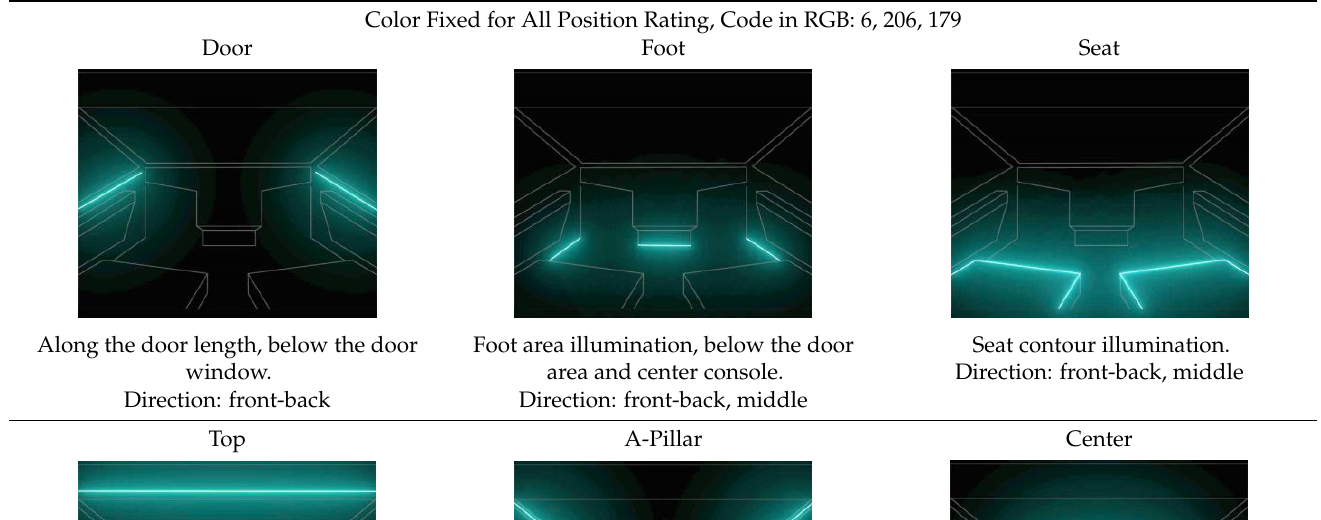
Table 2. Position settings used in the survey. Color Fixed for All Position Rating, Code in RGB: 6, 206, 179